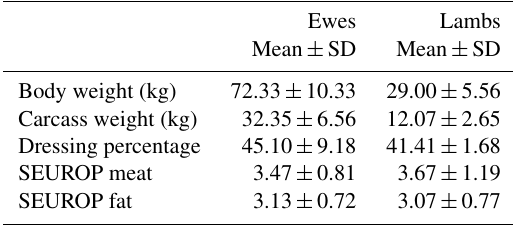
Table 2. Characteristics of slaughter